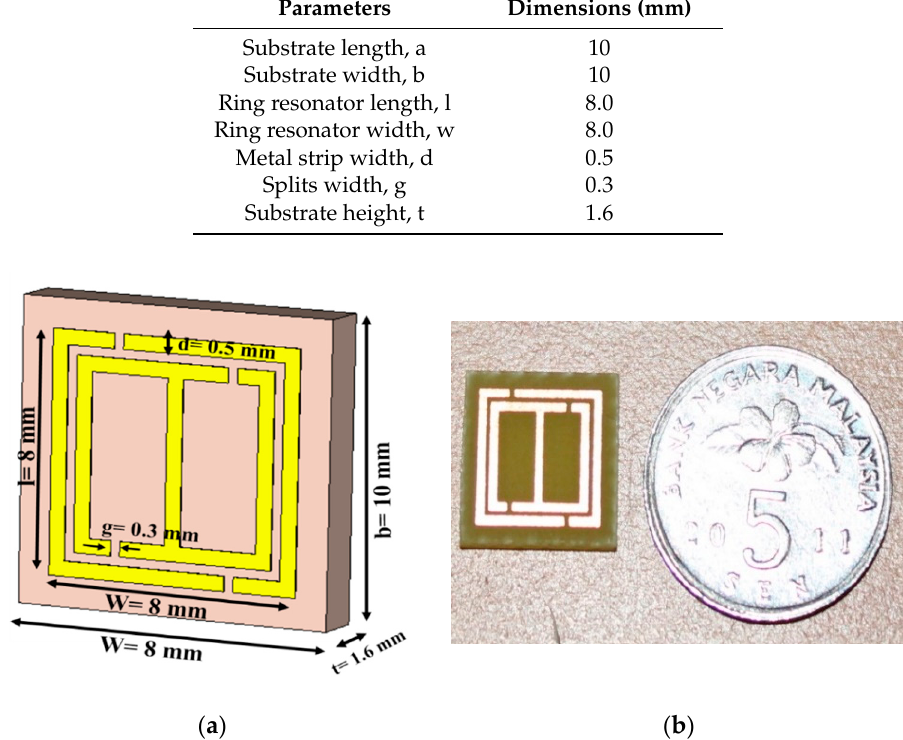
Figure 2. Meta-atom unit cell: ( a ) proposed structure, ( b ) fabricated structure.